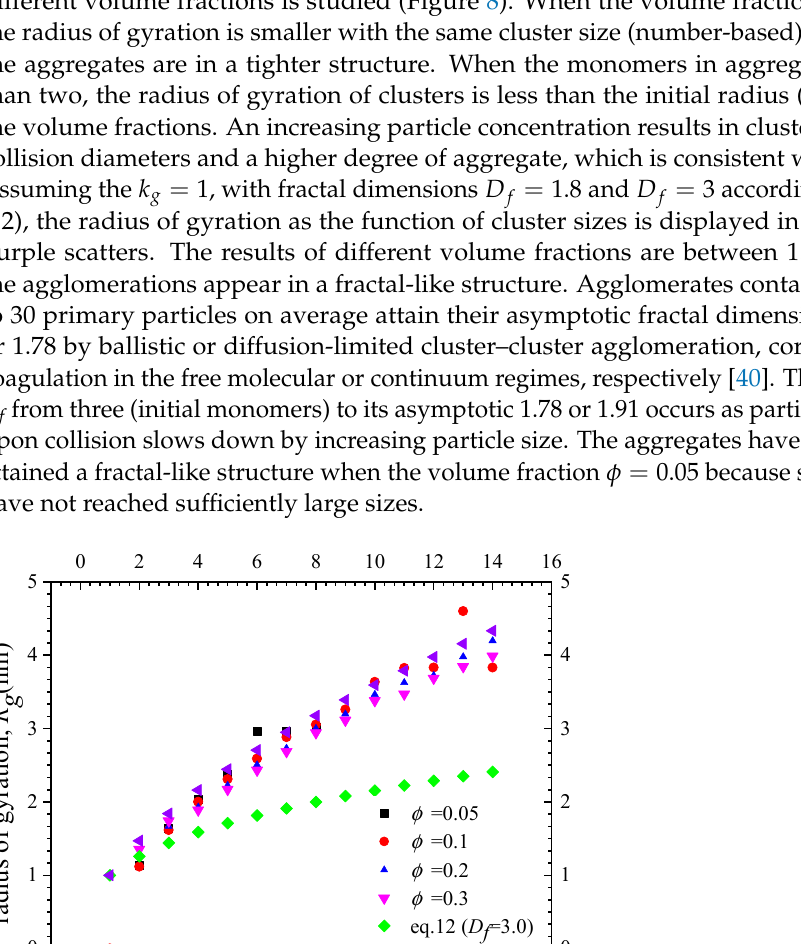
Figure 7. ( a ) Normalized particle size distributions; ( b ) geometric standard deviations with different volume fractions.